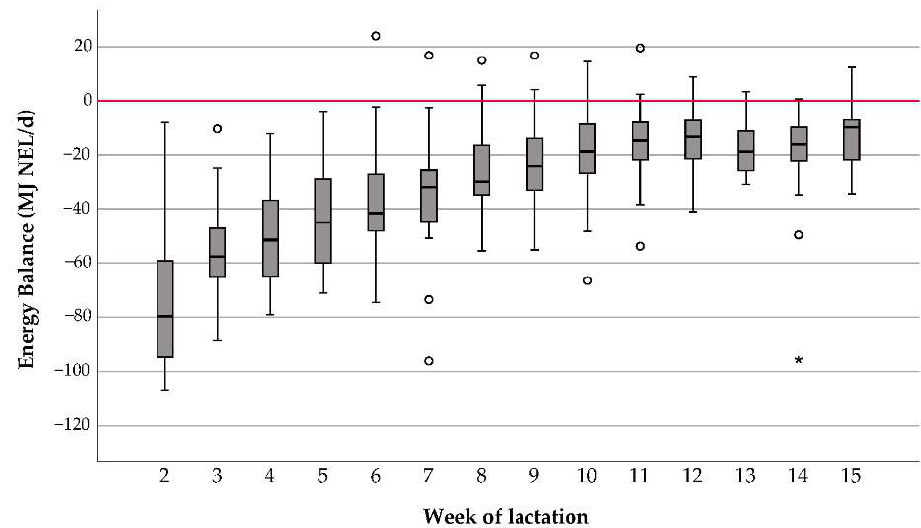
Figure 8. Energy balance (MJ NEL/d) of dairy cows ( n = 28) between weeks 2 and 15 postpartum (p.p.). In each subfigure, the boxplots respectively highlight the median, upper, and lower quartiles of each week. Box whiskers extended to the most extreme nonoutlier data points were considered as outliers if they lay more than 1.5 times the interquartile range from the edge of the box. Small circles = outliers (1.5 × interquartile range (IQR)); asterisks = extreme values (3 × IQR). Mean individual cow EB ranged between −56.4 ± 13.6 kg and 5.2 ± 14.0 MJ NEL/d ( p = 0.00; η 2 = 0.675), as shown in Figure 9. The CV of EB during the trial period ranged from 0.24 and 2.68 between individual animals.